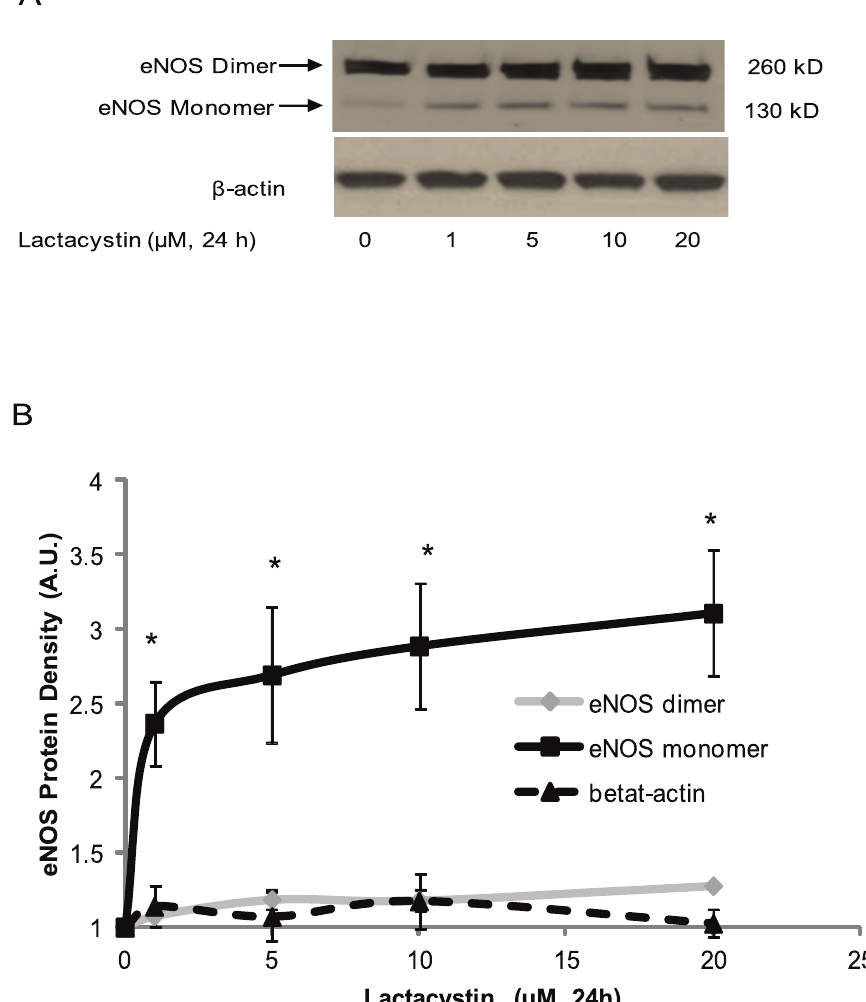
Figure 2. Inhibition of proteasome 26S resulted in an eNOS monomer accumulation in BAECs. BAECs were incubated with indicated concentration of lactacystin overnight. The protein was harvested with RIPA buffer and run on SDS-PAGE gel at low temperature (4 u C) and the eNOS monomer and dimer content was assessed by western blot and quantified using densitometry. (A) Lactacystin caused a dose-dependent accumulation of eNOS monomer but not dimer; (B) The eNOS monomer and dimer in BAECs were normalized with the controls (0 h) and represented as mean 6 SE from four independent experiments. * P , 0.05 comparison with control.